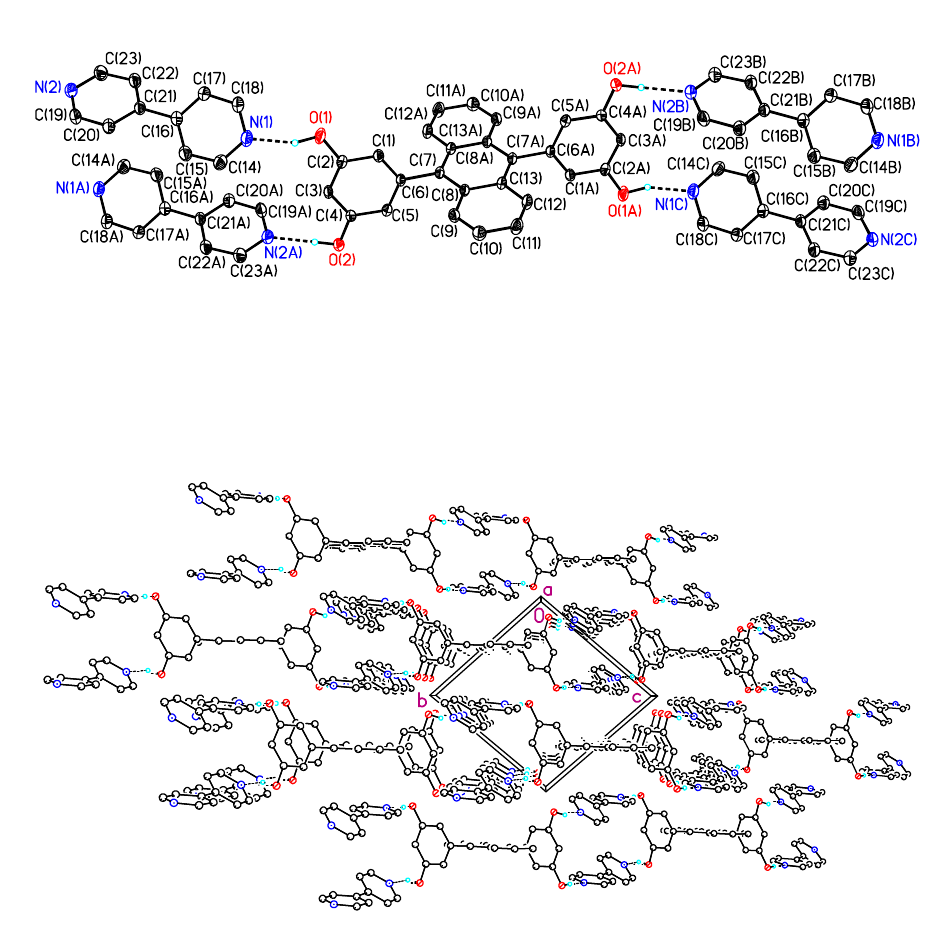
Figure 1 (a) The crystal structure of 1. Hydrogens were omitted for clarity. (b) The crystal-packing of 1 viewed down the a axis. Notice that 1 leads to infinitely rectangular macrocycles, whose sizes are ca